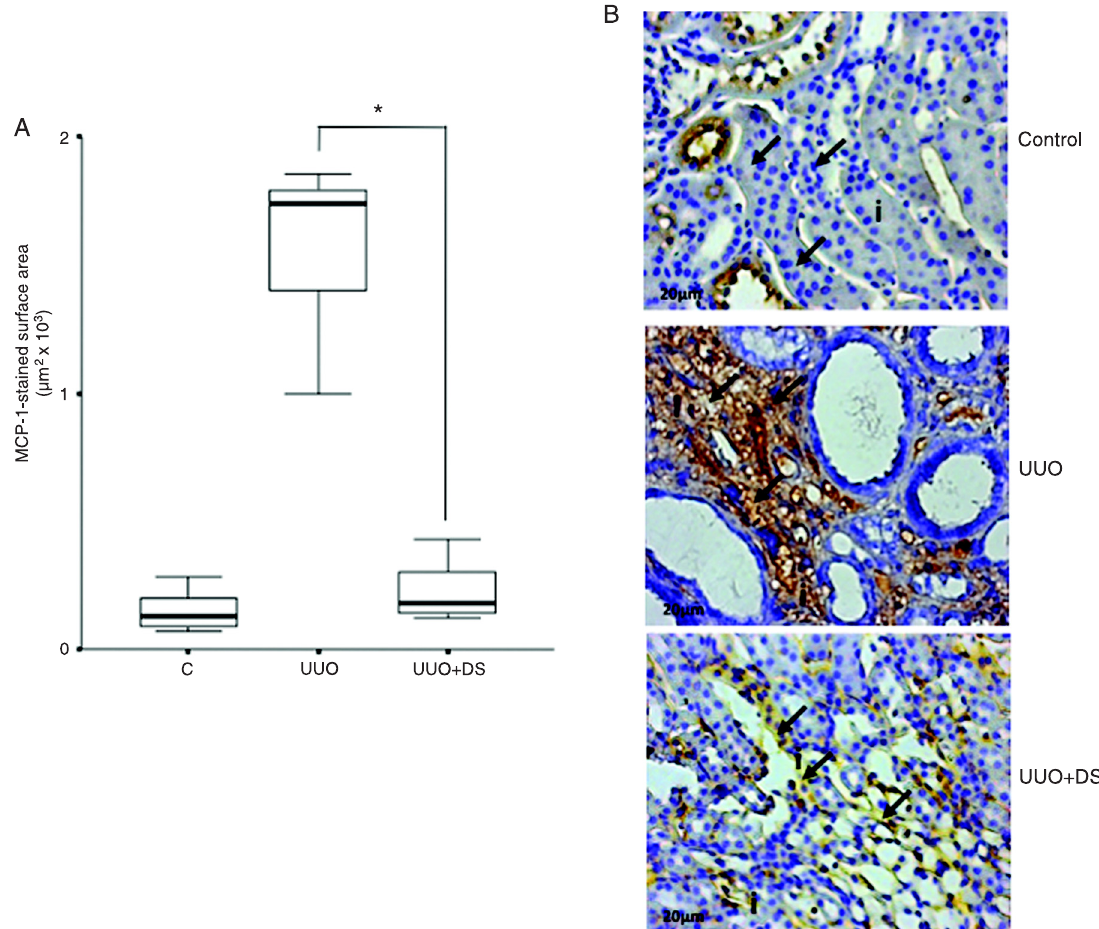
Figure 5. Monocyte chemoattractant protein-1 (MCP-1) content in kidneys from mice submitted to different treatments. A , Immunohis- tomorphometry of anti-MCP-1-stained sections of kidneys of mice from group C (control kidney), group unilateral ureteral obstruction (UUO), and group unilateral ureteral obstruction plus dermatan sulfate (UUO+DS). The horizontal bars represent medians, the boxes represent the 25th and 75th percentiles, and the vertical bars represent the ranges, N = 30. B , The arrows in the UUO panel point to strong MCP-1-stained interstitial areas compared with those with less intense staining in control and UUO+DS panels. i = interstitium. Scale bar = 20 µm. Magnification 400X. *P < 0.05